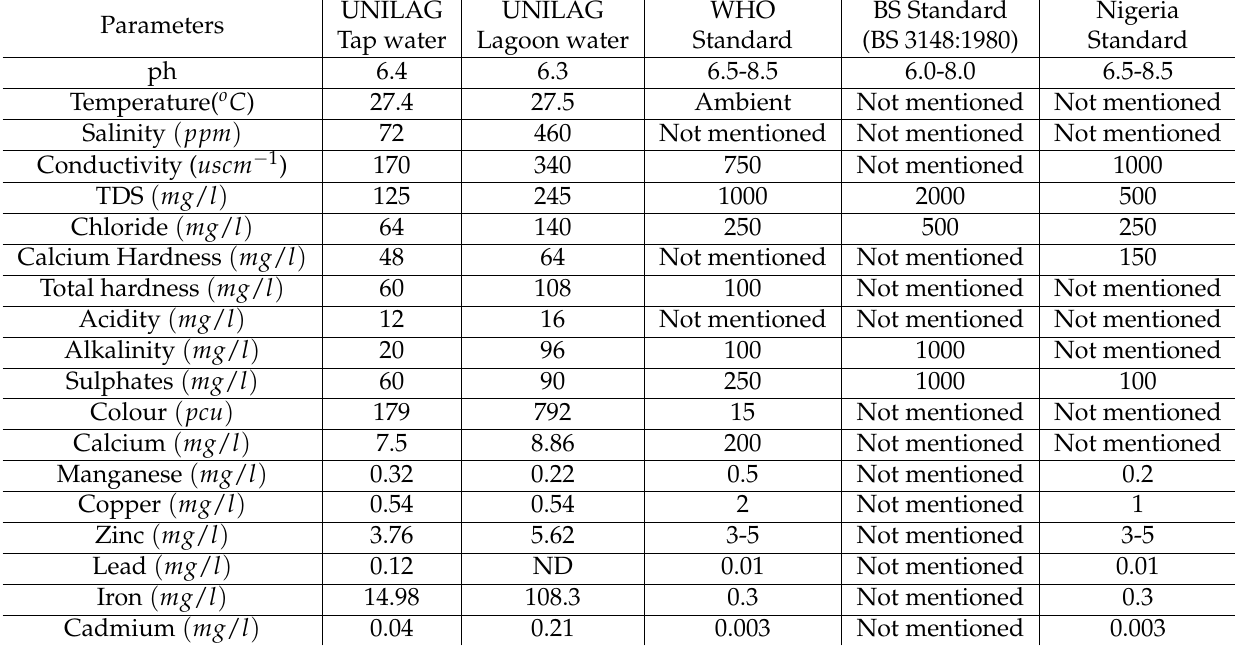
Table 2. Physio-chemical properties of different curing medium